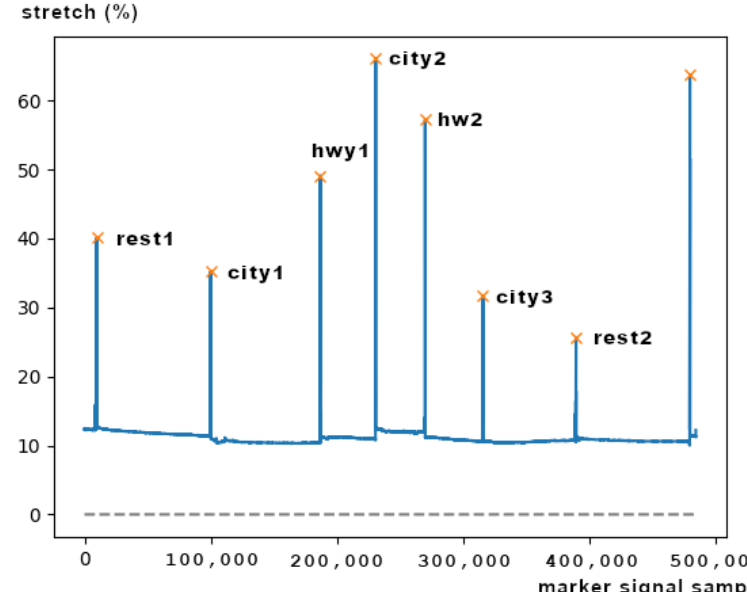
Figure 2. DriveDB driving event segments and peaks of the marker signal, created using a respira- tion